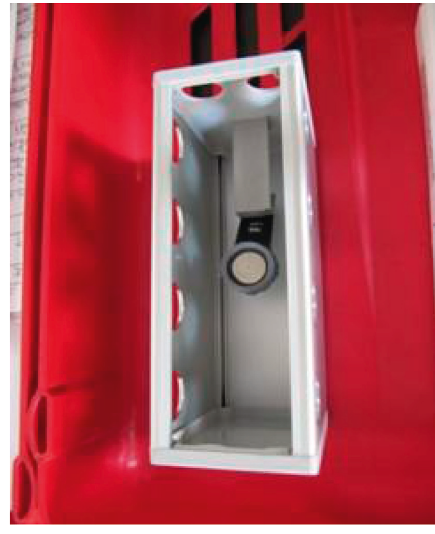
Figure 4: Coin-type data